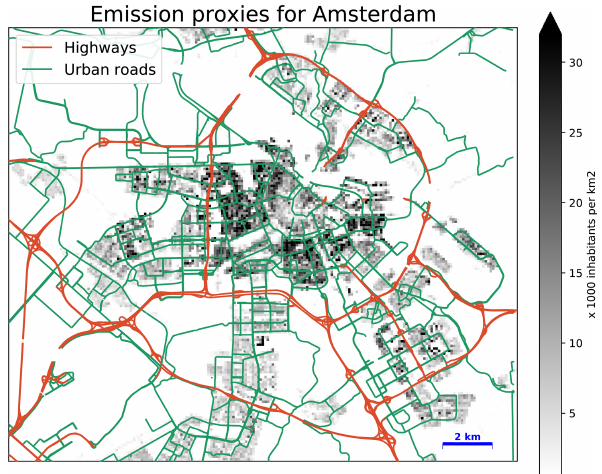
Figure 2. Map of the emission proxies used for the dispersion model. Red lines indicate the highways; green lines indicate the ur- ban main roads. Grey colours indicate the population density. (Road location data adopted from © OpenStreetMap contributors 2019.